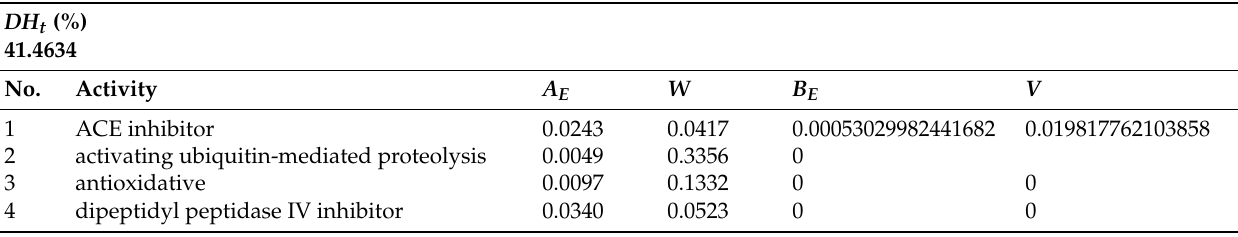
Table A48. A E , DH t , W , B E and V values from RubisCO of Halophila stipulacea . In silico enzymatic cleavage carried out by using proteinase P1 (lactocepin).